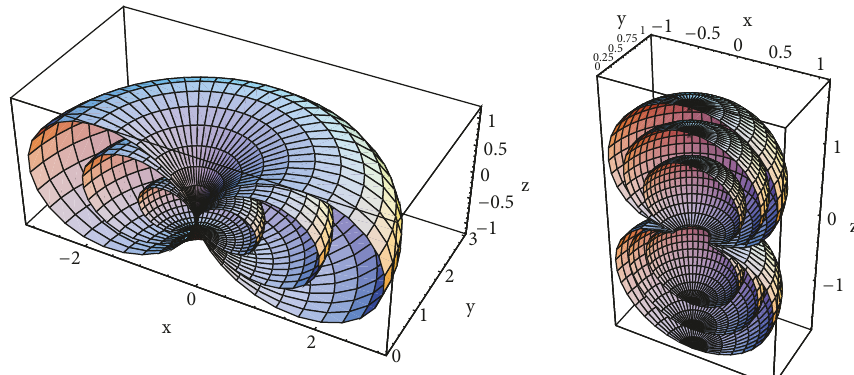
Figure 11: Left: coordinate surfaces of constant 𝑎 = 1,2,3 (tori-like); Right: coordinate surfaces of constant 𝑏 = 1,2, 3 (double-volumes). The dipole is directed along 𝑧